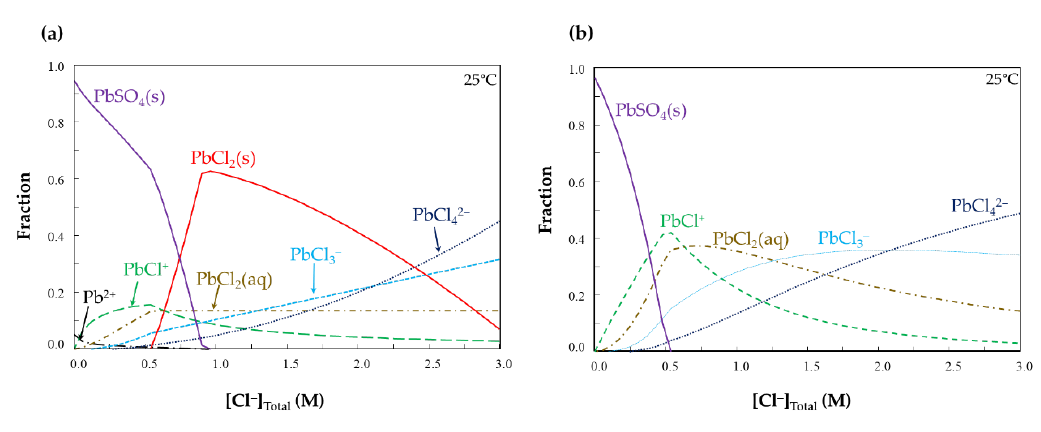
Figure 12. Effects of solution compositions on Zn removal from ZPLRs with and without ZVAl addition: ( a ) 0.01 M HCl and 0–3 M NaCl, ( b ) 0.05 M HCl and 0–3 M NaCl, and ( c ) 0.1 M HCl and 0– 3 M NaCl.